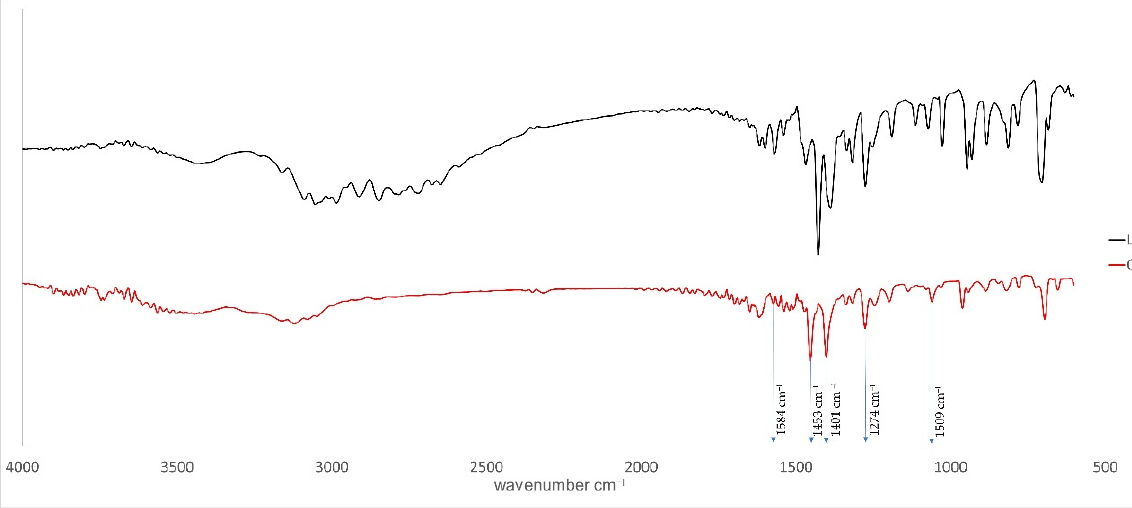
Figure 4. FTIR spectrum of free organic ligands L4 and complex C4.